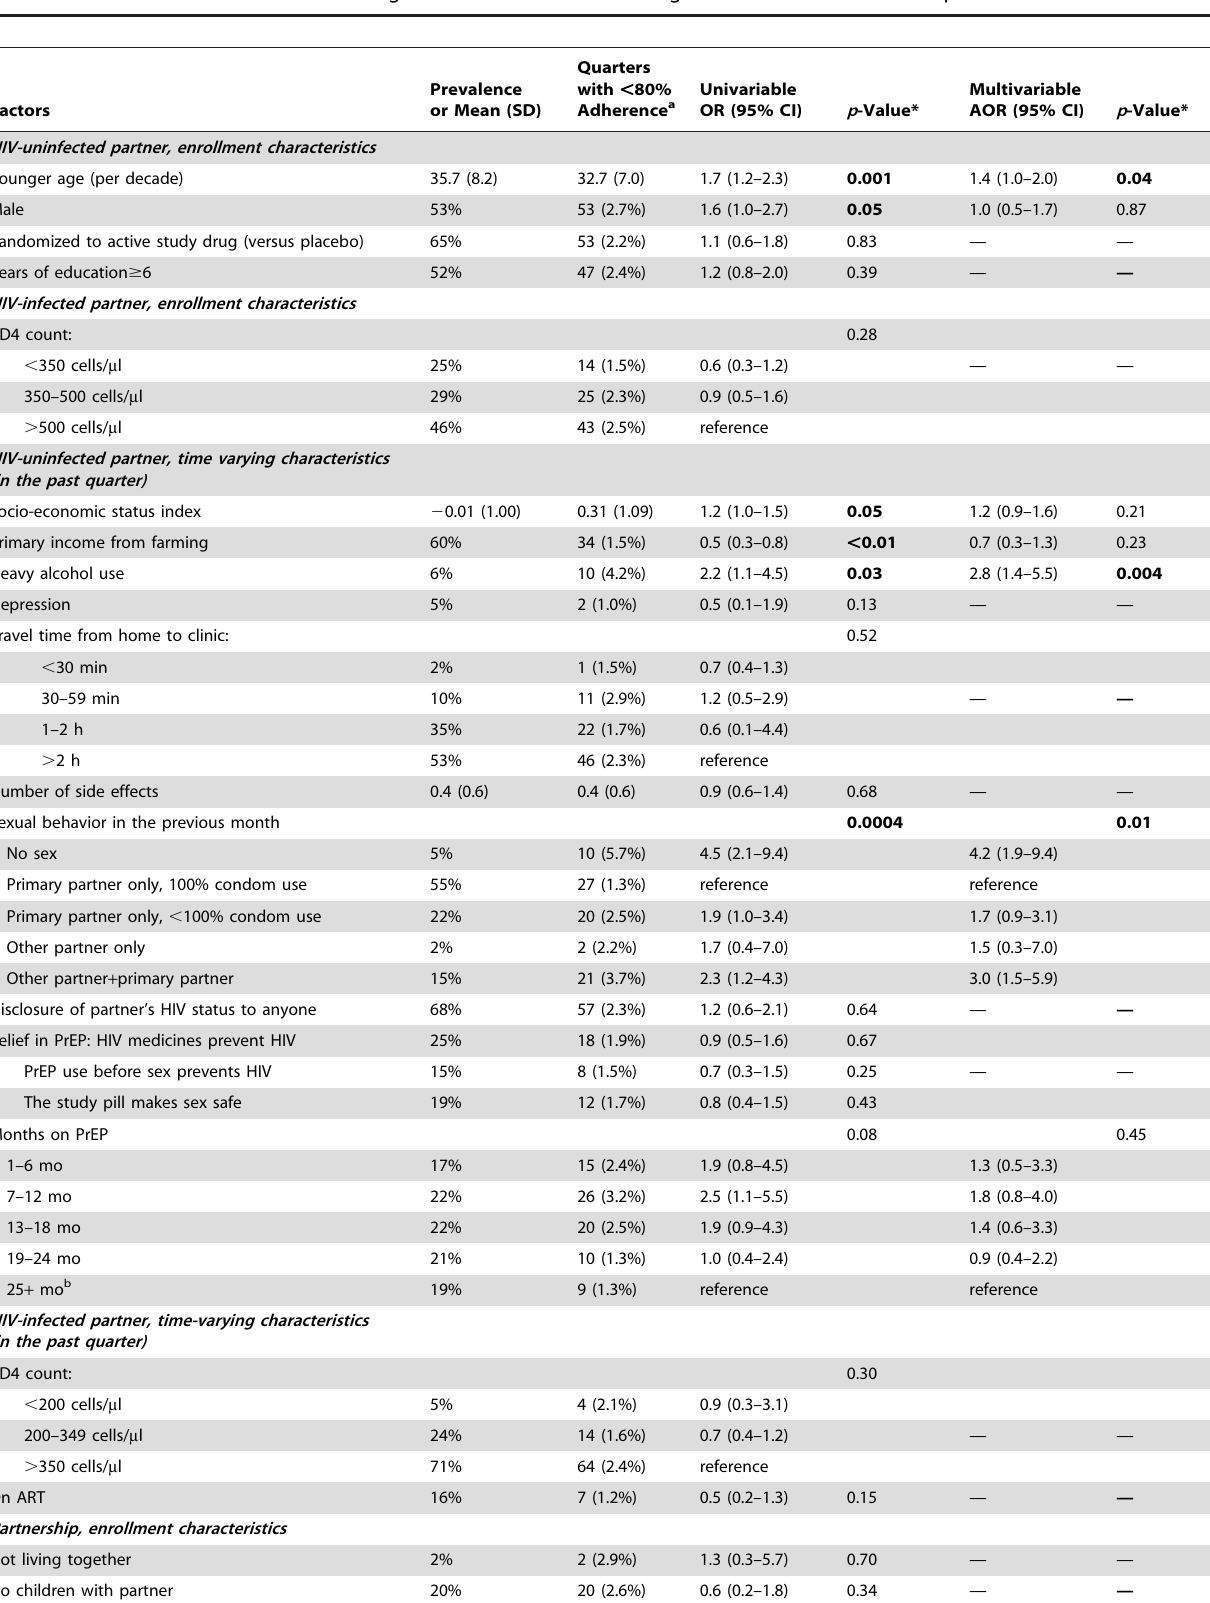
Table 3. Univariable and multivariable regressions of factors correlating with , 80% unannounced pill count.